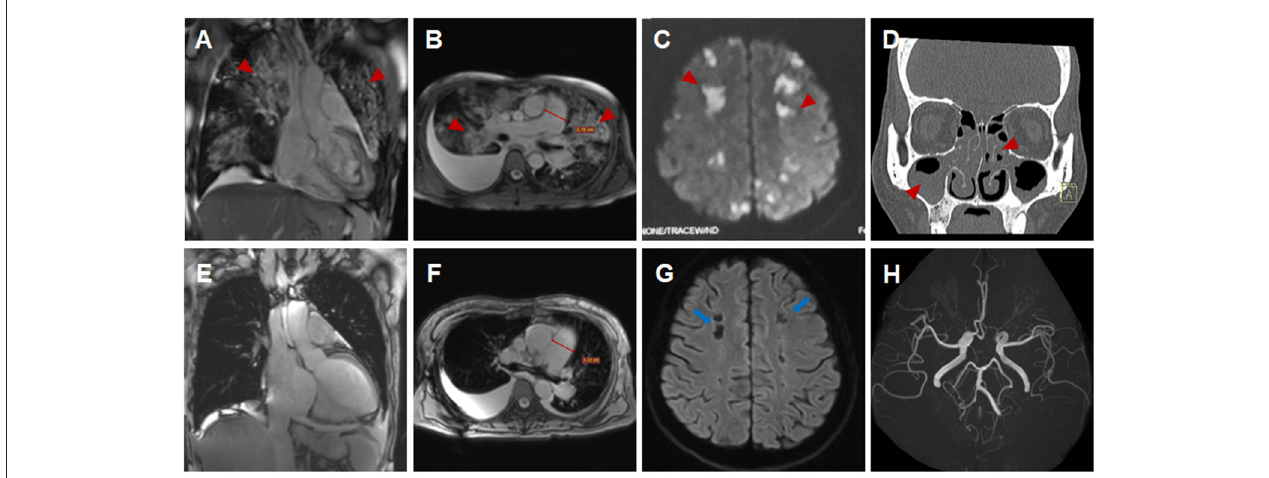
FIGURE 1 | Imaging findings of eosinophilic granulomatosis with polyangiitis (A–D,H) Imaging findings during the initial hospitalization ( A,D , coronal view; B,C,H , transverse view). Multiple patchy consolidations of both lungs ( A,B , triangular arrows) on CMR images, multiple acute cerebral infarctions ( C , triangular arrows) with no obvious cerebrovascular stenosis ( H , triangular arrows) on brain MR images and sinusitis and nasal polyps ( D , triangular arrows) on reconstructed CT images. (E–G) Imaging findings during the subsequent hospitalization ( E , coronal view; F,G , transverse view). Significantly absorbed multiple lesions of both lungs ( E,F ), the pulmonary hypertension with increased diameters of pulmonary trunk from 28mm (B) to 32mm (F) and multiple encephalomalacia ( G , long